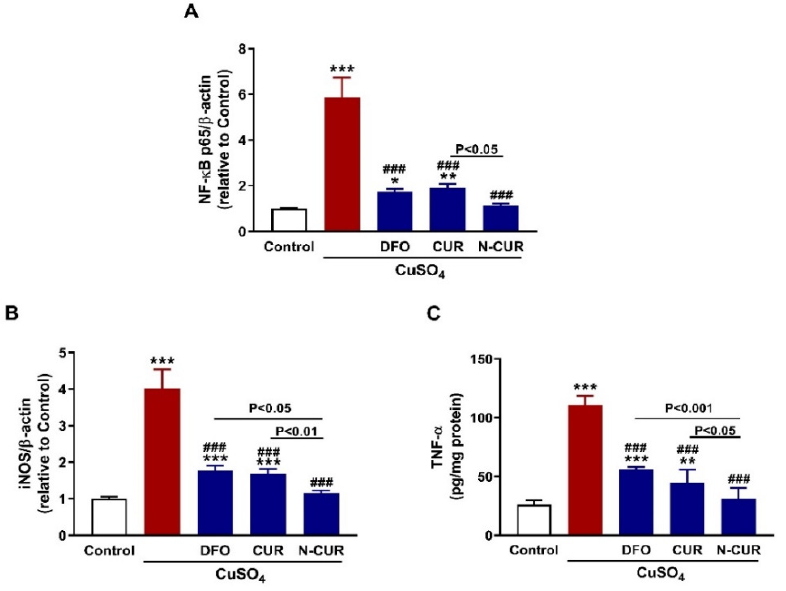
Figure 6. N-CUR and CUR mitigate testicular inflammation in Cu-intoxicated rats. CUR, N-CUR, and DFO decreased ( A ) NF- κ B p65 and ( B ) iNOS mRNA abundance, and ( C ) TNF- α protein. Data are mean ± SEM, ( n = 8). * p < 0.05, ** p < 0.01 and *** p < 0.001 versus Control, and ### p < 0.001 versus CuSO 4 .